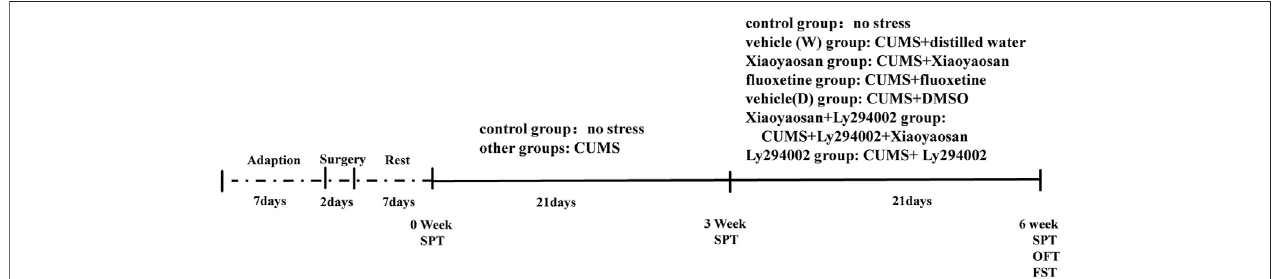
FIGURE 1 | Timeline of the experiment. Before the experiment, the animals were allowed a 7-days adaptation period. The rats in the surgery groups underwent lateral ventricular catheterization and were allowed to recover for one week. Except for the control group, the rats in the other groups were subjected to CUMS for 6 weeksand treatedwithdifferentdrugs fromthefourth weektothesixthweek. Thebody weights and foodintake levelsweremonitored weekly.ASPTwasperformed on day 0 (baseline SP test), day 21 and day 41. The OFT and FST were performed in week 6. Then, the rats were sacri fi ced for further detection.